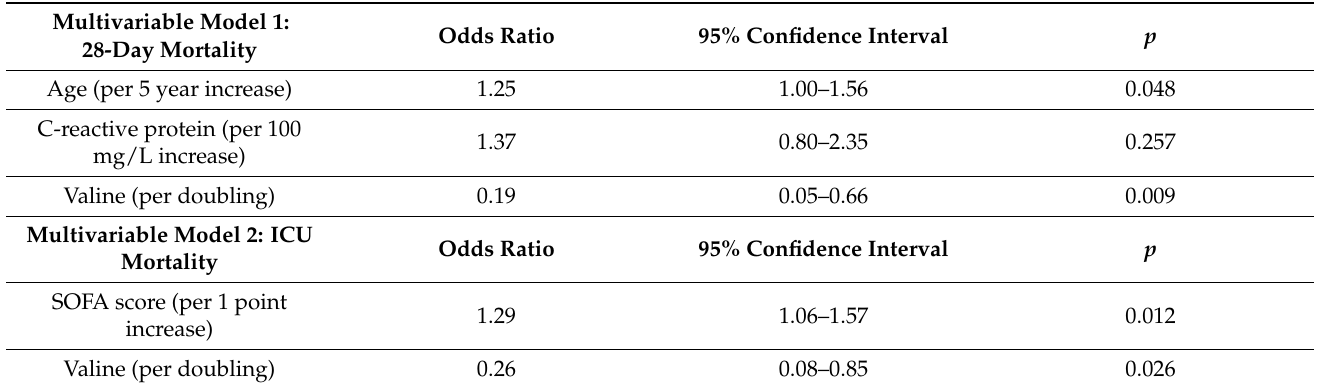
Table 6. Multivariable logistic regression models in sepsis patients for the prediction of 28-day and ICU mortality. Multivariable Model